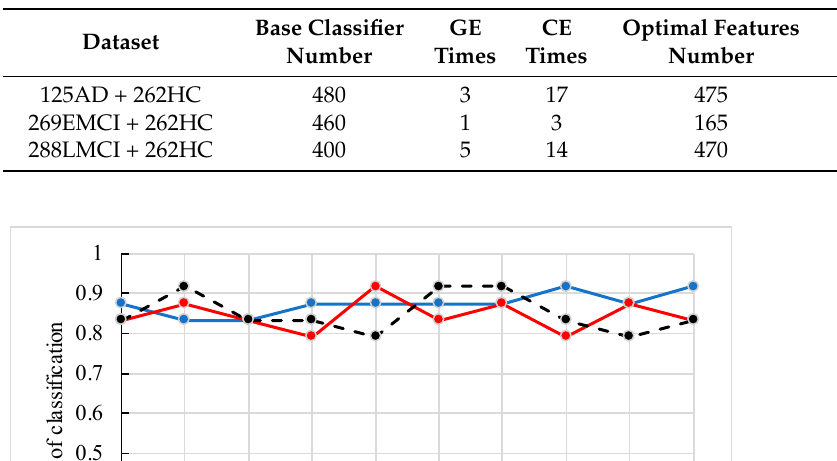
Table 4. Model validation experiments on different datasets. GE = genetic evolutionary times; CE = clustering evolutionary times; HC = healthy control; EMCI = early mild cognitive complaint; LMCI = late mild cognitive complaint; AD = Alzheimer’s disease.